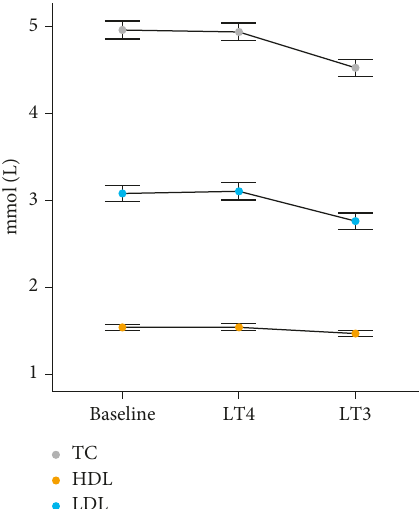
Figure 2: A multiple line graph showing mean ( ± 95% confidence intervals) serum levels of total cholesterol (TC), HDL cholesterol, and LD cholesterol in mmol/L measured at the baseline visit and after both treatment periods with LT4 and LT3.